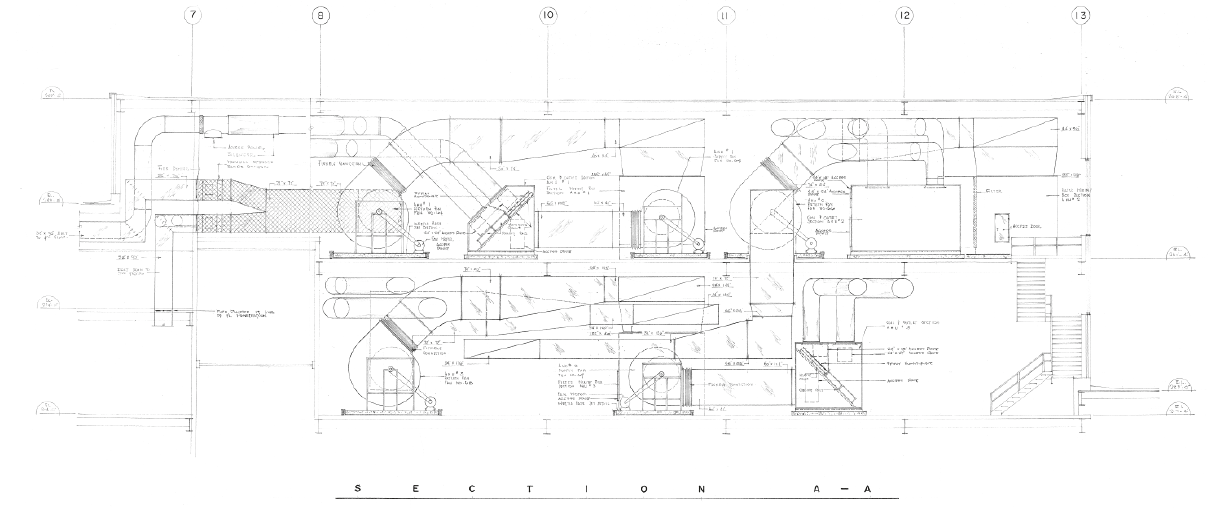
Figure 7: Main room’s ventilation system.